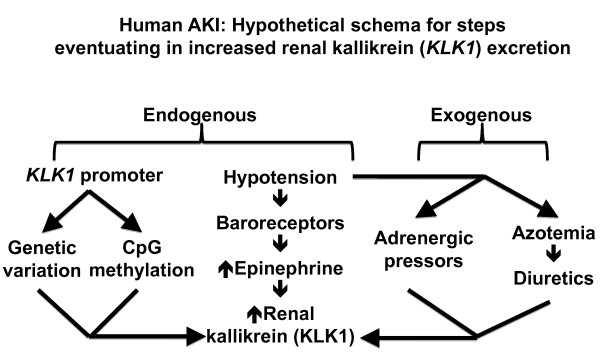
Hypothetical schema integrating experimental findings in this study of KLK1 in AKI. This diagram is presented not as established fact, but rather to generate hypotheses for further investigation. Endogenous factors may influence KLK1 synthesis and renal excretion: lower BP in AKI may activate baroreceptors, thus increasing endogenous secretion of epinephrine, thereby increasing both heart rate and urinary kallikrein excretion. KLK1 promoter genetic variants or CpG methylation can influence renal kallikrein production. Finally, exogenous factors such as adrenergic pressor infusions or diuretic treatment can also increase renal kallikrein production; indeed, since a subset of our AKI cases received such treatments (Table 1), we cannot exclude this possibility.